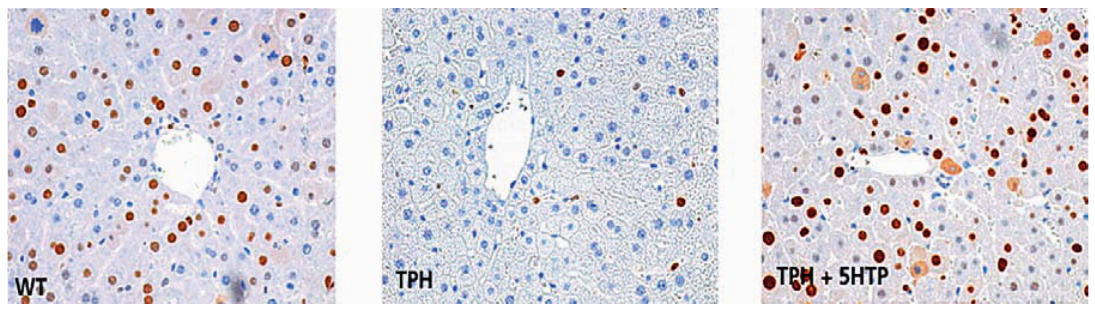
Representative proli- ferating cell nuclear antigen (PCNA) stai- ned sections from remnant livers showing decreased he- patocyte proliferation 2 days after hepatec- tomy in TPH-1 knock- out (TPH) compared with wild type (WT) mice and restoration of liver regeneration by serotonin reload - ing (TPH+5HTP). [Adapted from: